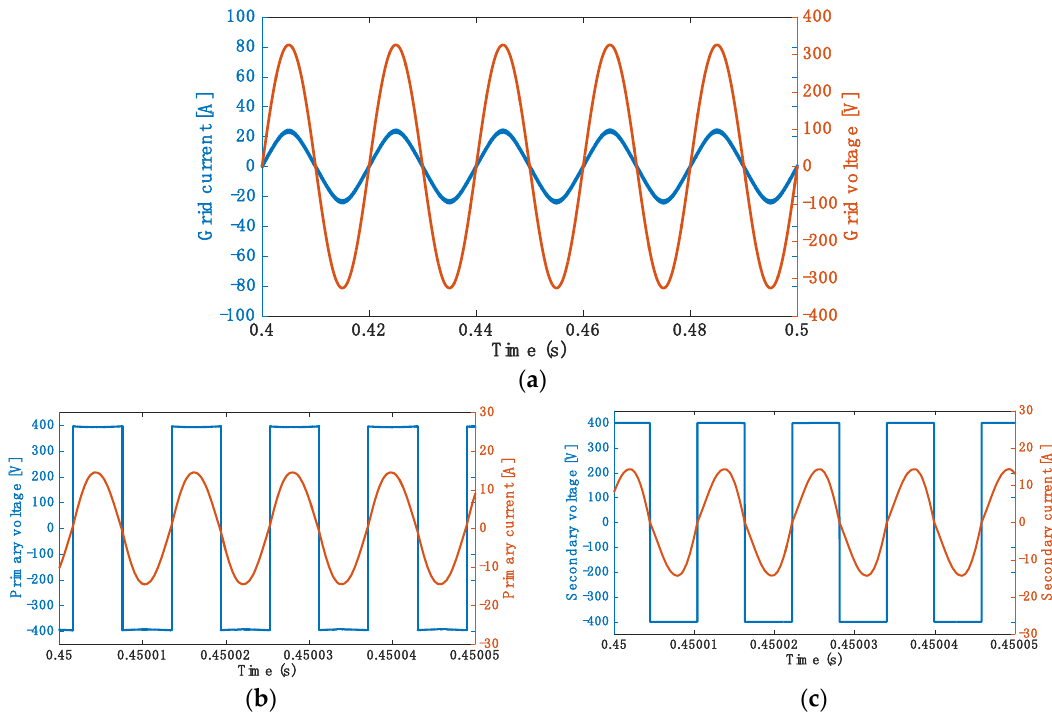
Figure 15. G2V: ( a ) Grid voltage and current; ( b ) Primary resonant voltage and current; ( c ) Secondary resonant voltage and current.